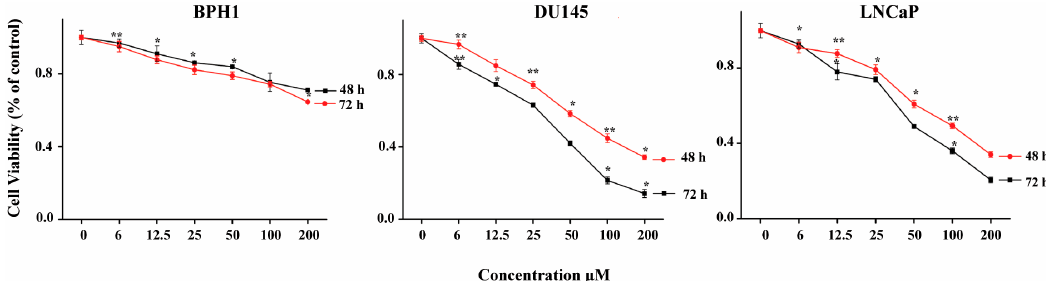
Figure 1. Cytotoxicity of atractylenolide II (ATR II) on prostate cancer and normal cells line. DU145 and LNCaP prostate cancer cells line, as well as BPH1 prostate normal cells line, were treated with increasing concentrations 0, 6, 12.5, 25, 50, 100, and 200 µM of ATR II, Proliferation was assessed after 48 h and 72 h, as described in Materials and Methods. Each bar represents the mean ± standard deviation of three experiments. * p < 0.05; and ** p < 0.01 compared with the control.